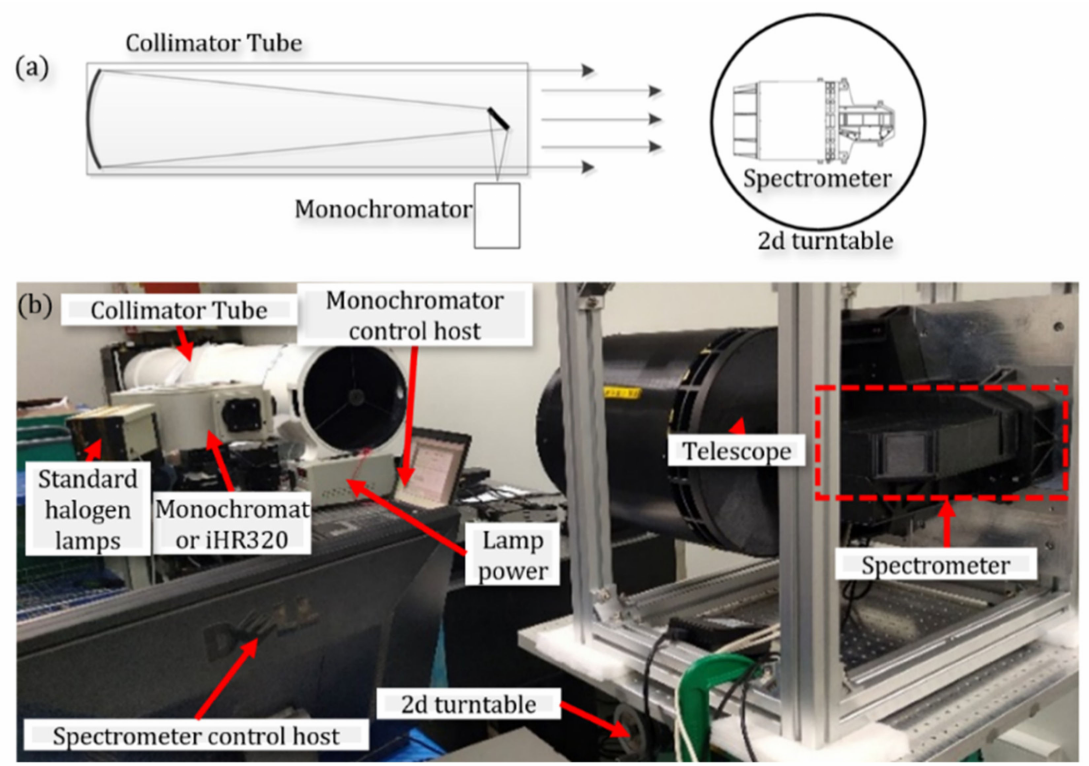
Figure 6. System spectral calibration schematic ( a ) and physical diagram ( b ).